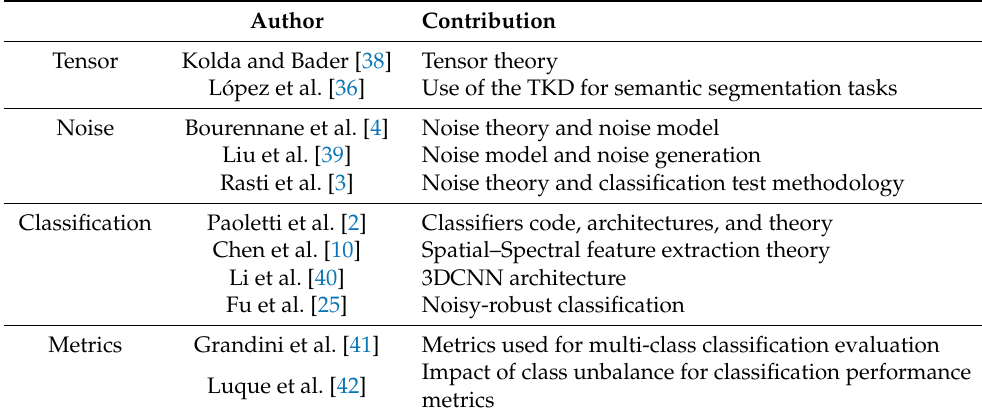
Table 1. Main papers used for the proposed framework and its